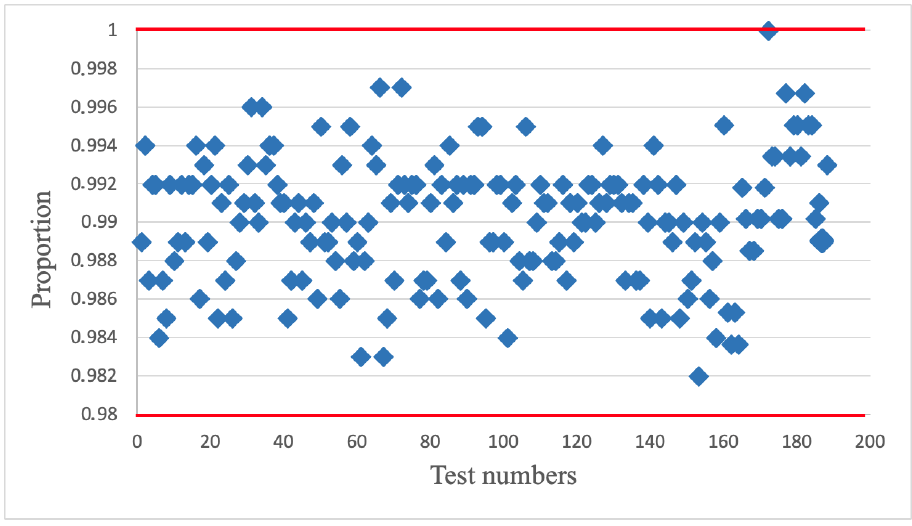
Figure 6. Statistical portrait of the combined PRBSG.